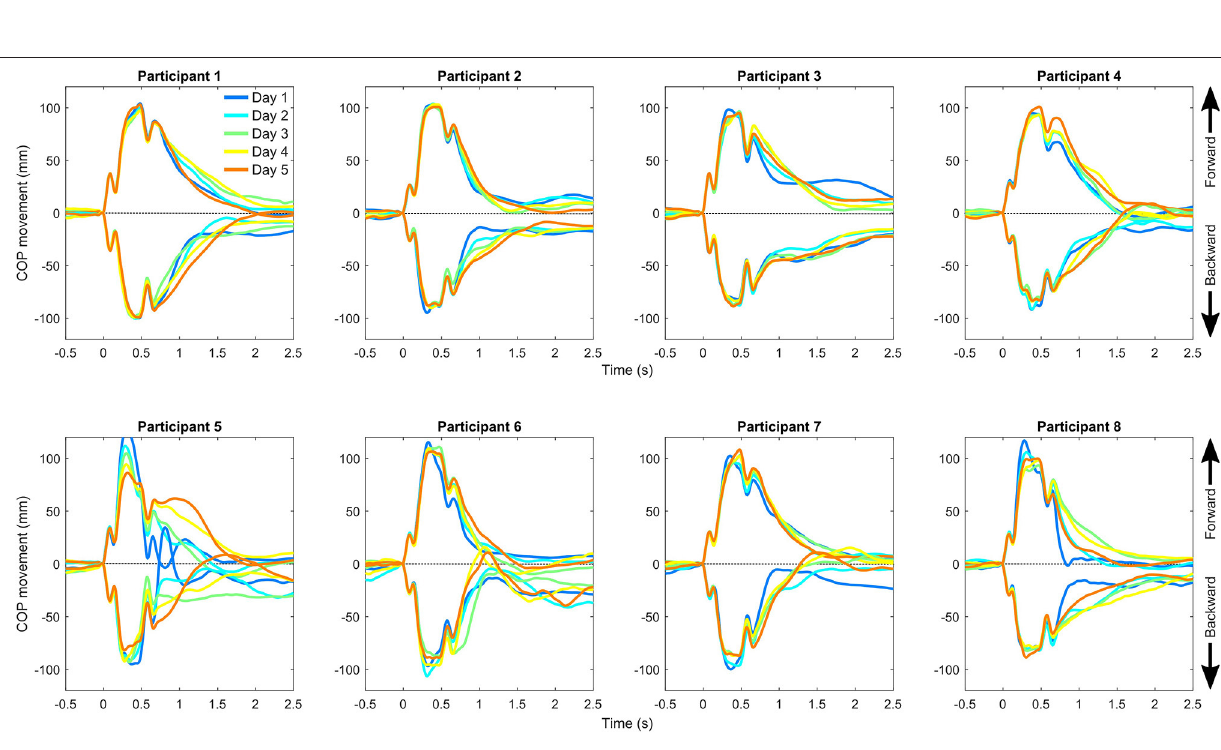
Frontiers in Sports and Active Living |